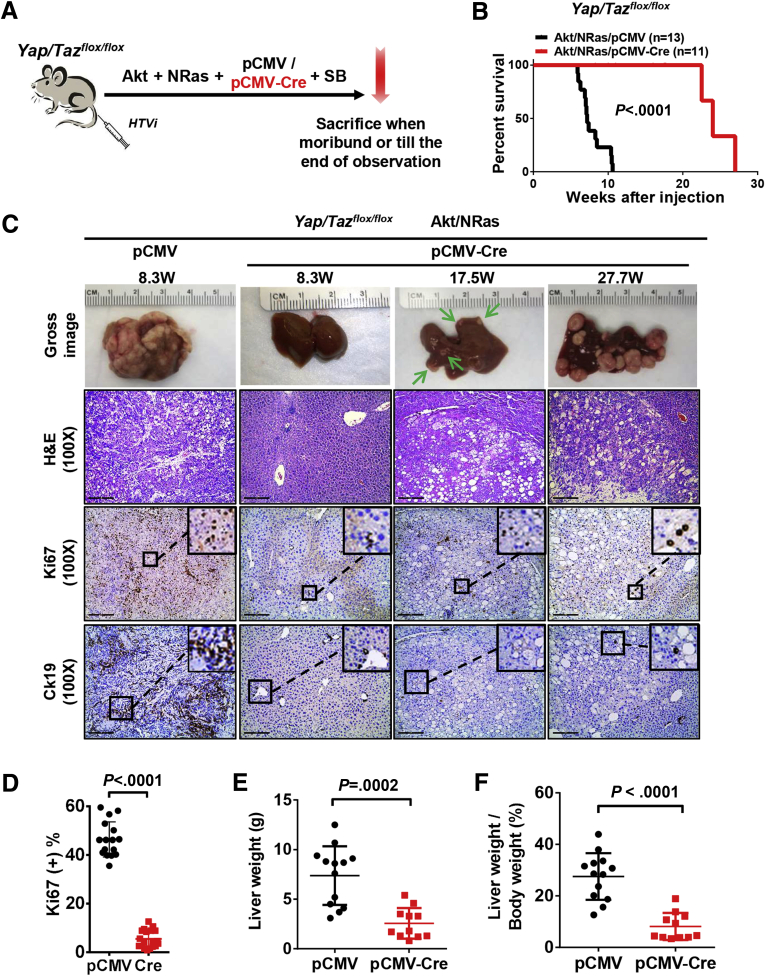
Concomitant depletion of Yap and Taz significantly impairs Akt/NRas-induced murine hepatocarcinogenesis. (A) Study design. Yap/Tazflox/flox conditional KO mice were injected hydrodynamically with Akt/NRas/pCMV (control; N = 13) or Akt/NRas/pCMV-Cre (N = 11) plasmids. (B) Survival curves of Yap/Tazflox/flox conditional KO mice injected with Akt and NRas. (C) Macroscopy comparisons of Akt/NRas liver tumor development in pCMV and pCMV-Cre groups (upper row), histopathologic features of the lesions (second row), Ki67 (third row), and Ck19 (fourth row) immunohistochemistry in both pCMV and pCMV-Cre groups. Scale bar: 200 μm for magnification of 100×, 100 μm for magnification of 200×. (D) Percentage of Ki67-positive cells in tumors. (E and F) Comparisons of (E) liver weight and (F) liver-weight-to-body-weight ratios in Yap/Tazflox/flox murine Akt/NRas liver tumors.